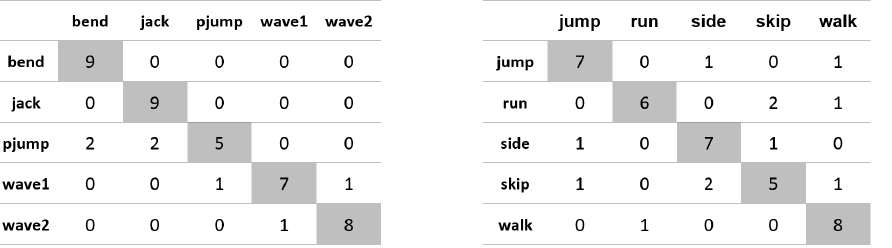
Figure A17. Confusion matrices for the experiment using the ‘lower-occlusion’ database, shorterMBR and C1 correlation.